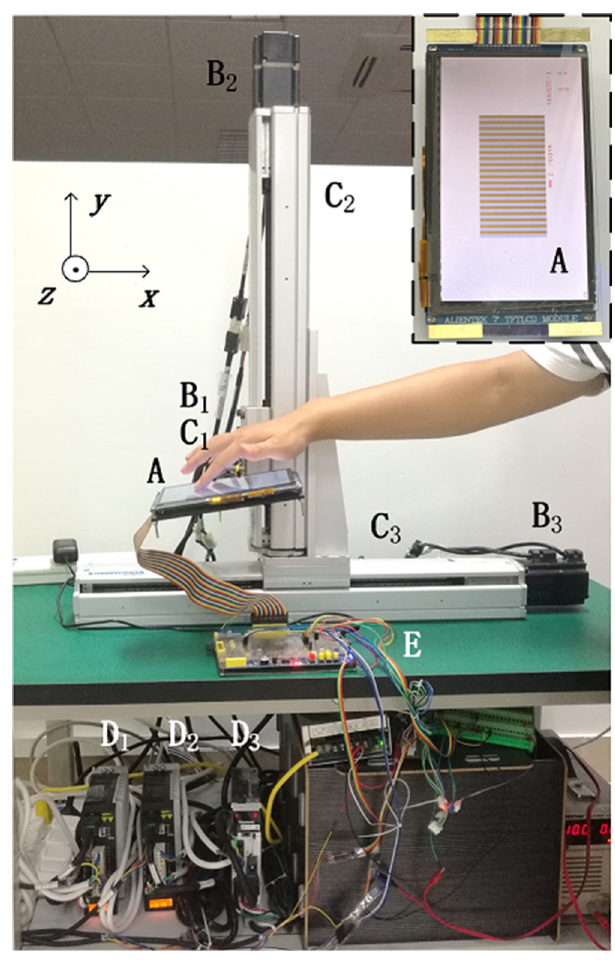
Fig. 1. Proposed system to produce curved and textured surface stimuli. A isthetexture-renderingplatethathastwofunctions:oneis astexturedisplayfortexturerendering;theotherisasorientedplate for curvature rendering. B1 , B2 , and B3 are servo motors (MSMD5AZG1U, Panasonic Inc.). C1 , C2 and C3 are lead screws (SFSR1610, Chuanwei Inc.) and terminal connector. The servo motors and lead screws form the servo mechanisms to elevate, translate, and rotate the texture-rendering plate. D1 , D2 , and D3 are motor controllers (A5, Panasonic Inc.). E is piezoelectric